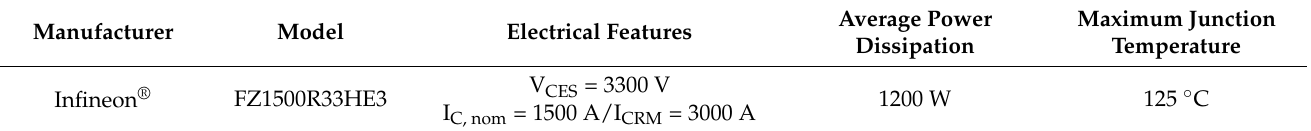
Table 4. Technical features of the IGBT module.